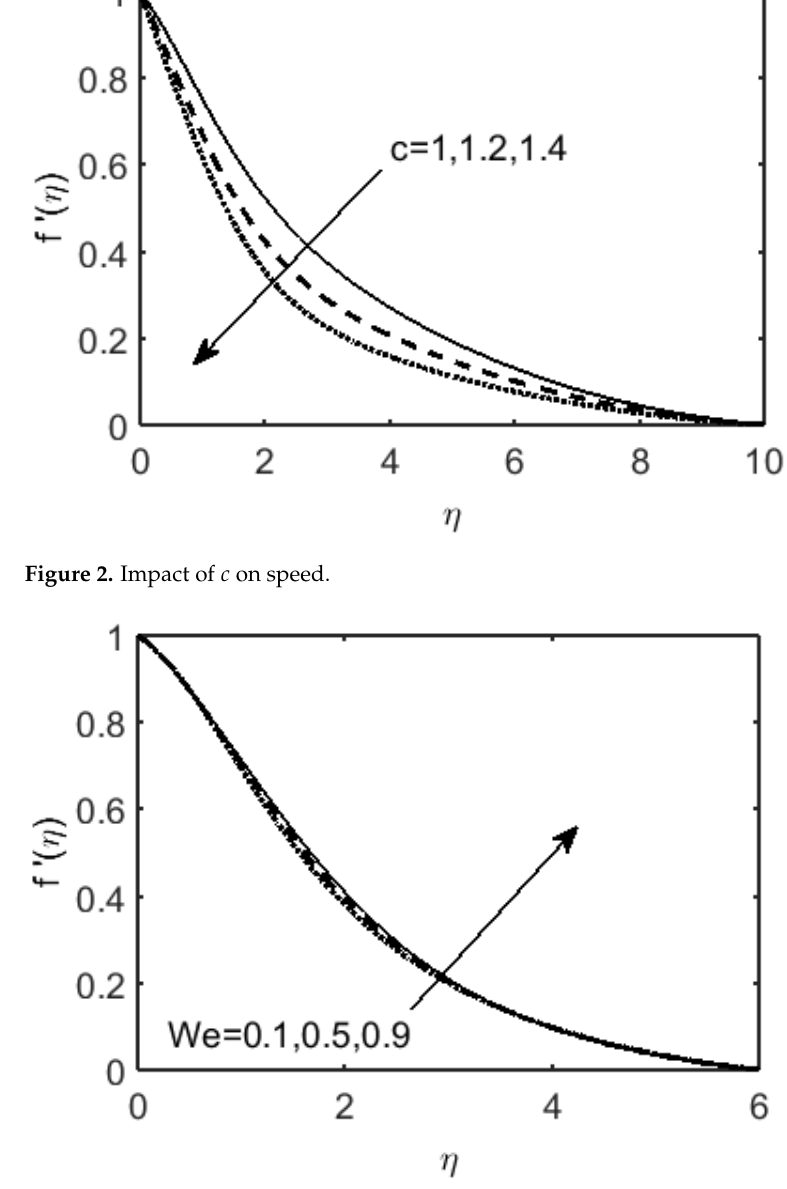
Figure 3. Impact of We on speed.